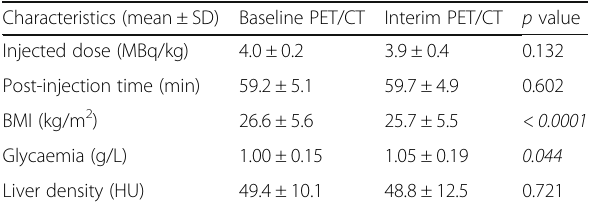
Table 2 PET/CT characteristics Characteristics (mean ± SD) Baseline PET/CT Interim PET/CT p